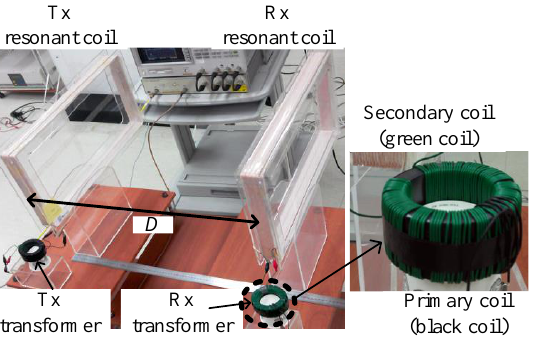
Figure 5. Photograph of the fabricated WPT system using both Tx and Rx transformers. Table 1. Measured parameters of the fabricated wireless power transfer (WPT) system.